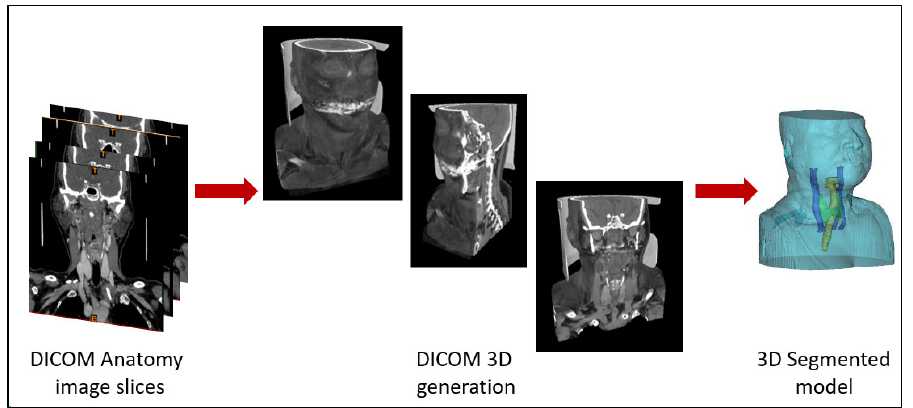
Figure 3. Representation of the DICOM anatomy imaging slices, illustrating the generation of the anatomy 3D generation and the correspondent segmented 3D model.